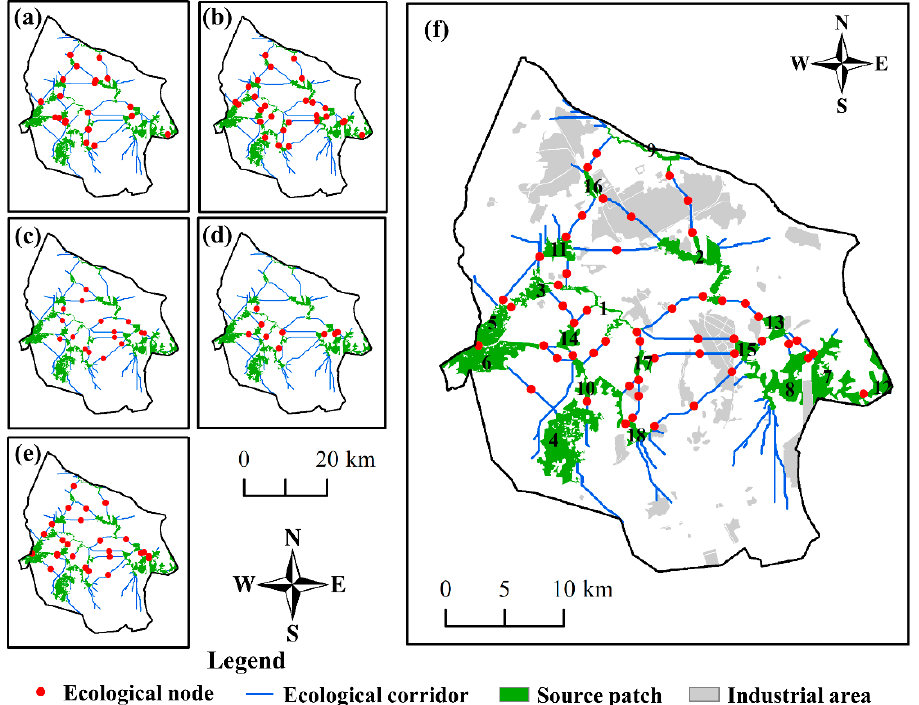
Figure 11. Distribution of the ecological nodes: ( a – d ) are the ecological nodes by circuit theory. ( a ) pinch points from Pairwise; ( b ) pinch points from All-to-one; ( c ) nodes recognized by Barrier Mapper based on improved scores; (d) nodes recognized by Barrier Mapper based on improved score percentages; ( e ) ecological nodes recognized by hydrological analysis; and ( f ) combined results of hydrological analysis and circuit theory.